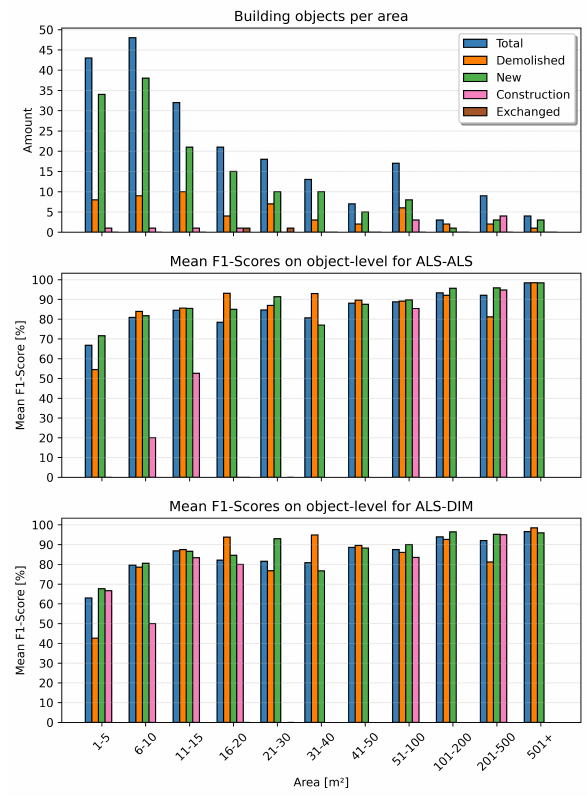
Figure 6. Change detection results using the HC + C building input at τ = 0 . 5 . Top row illustrates the overall amount of reference objects regarding their area size and change class. Middle and bottom row show the mean F 1 -Scores for ALS-ALS and ALS-DIM with with respect to their area size and change